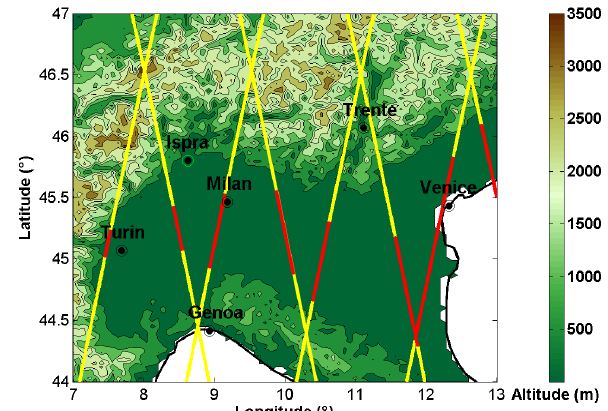
Fig. 1: Main cities and topography of the Po Valley region. The yellow solid lines represent Fig. 1. Main cities and topography of the Po Valley region. The the ground-tracks of CALIPSO orbits that have been considered. The red sections highlight yellow solid lines represent the ground-tracks of CALIPSO orbits the useful part of the orbits with a mean sea level (MSL) altitude lower than 0.2 km. that have been considered. The red sections highlight the useful part of the orbits with a mean sea level (MSL) altitude lower than